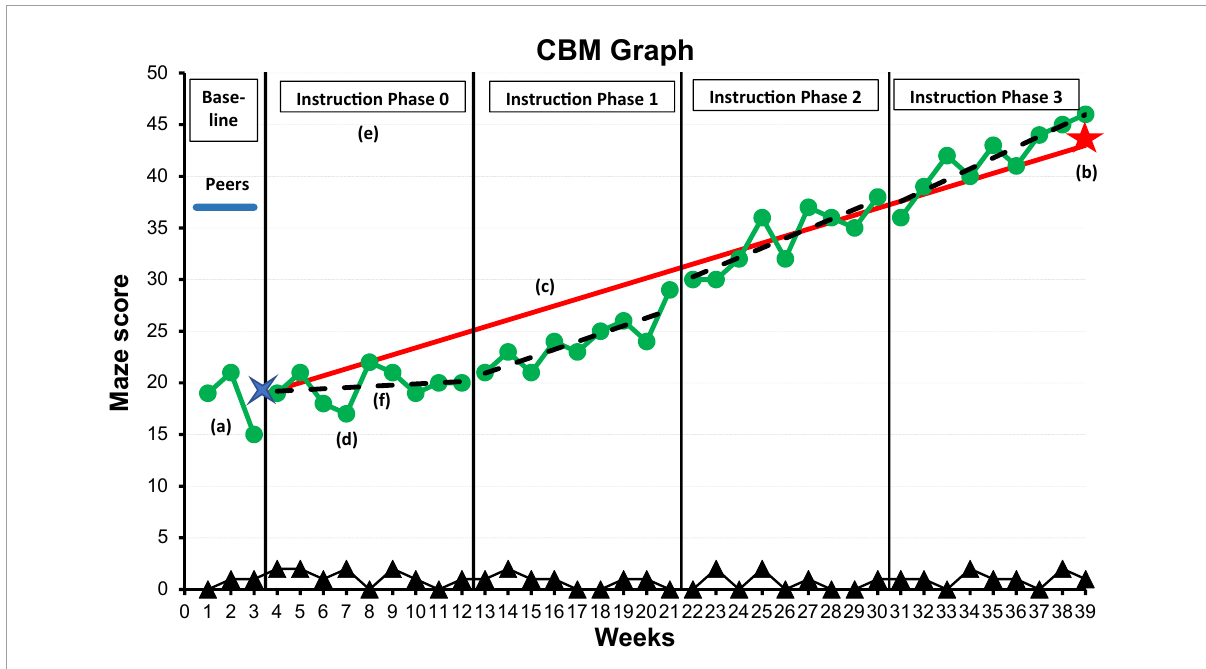
FIGURE1 Sample CBM progress graph: (a) baseline data; (b) long-range goal; (c) goal line; (d) data points; (e) phase of instruction; (f) slope (growth)